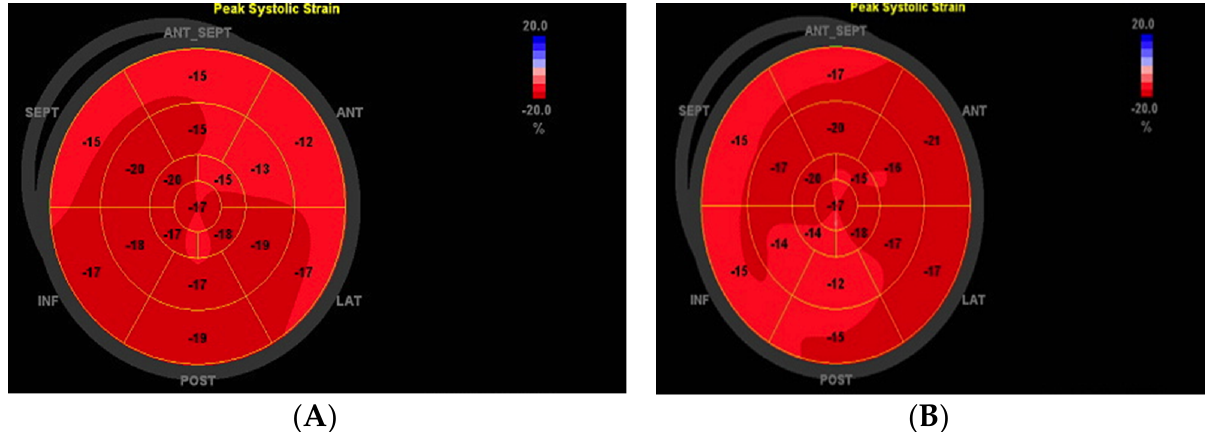
Figure 1. Example illustration of speckle-tracking analysis. ( A ) Assessment of 2-dimensional strain in a patient from HFpEF and ( B ) in a patient from HTN group.